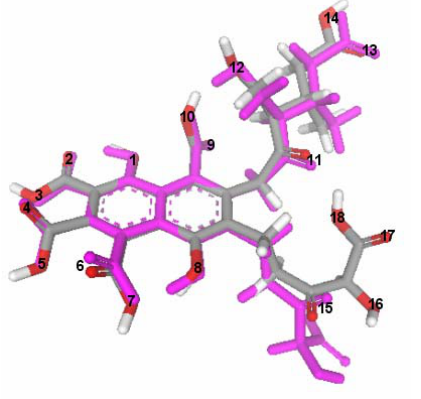
Figure 4. Fitted structures of FA (atom-type color) and ionized FA